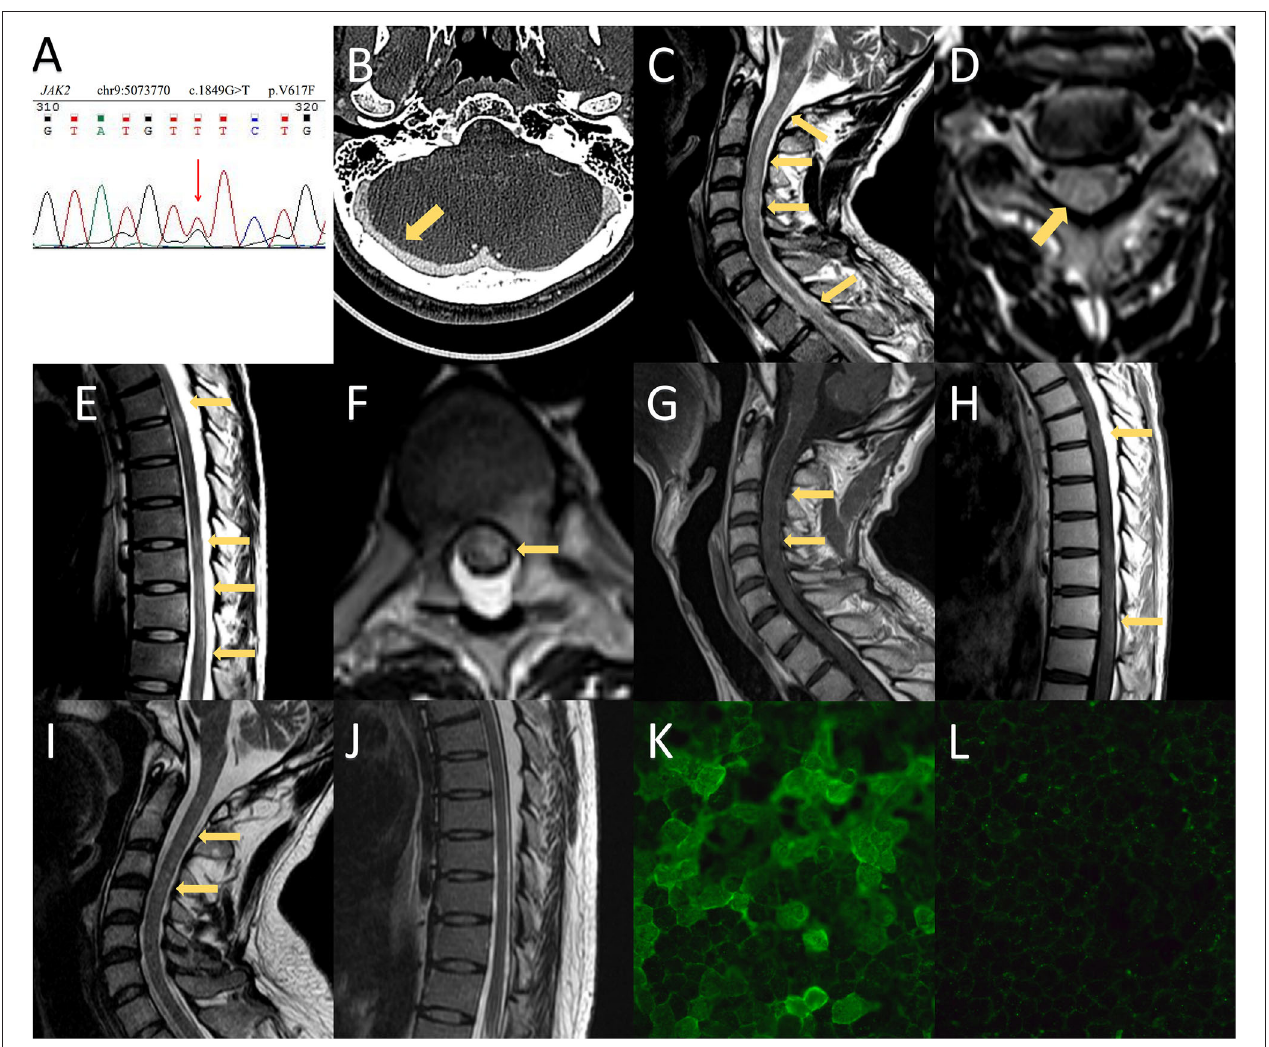
FIGURE 2 | MRI and CT findings and anti-aquaporin-4 antibody (AQP4-IgG) array of the presented case. (A) Whole-exome sequencing revealed a mutation in JAK2-V617F. (B) CT venography of the second hospitalization showed no filling defects of the cerebral venous sinus. (C–H) Spinal MRI demonstrated T2-weighted imaging abnormalities in the medulla as well as extensive spinal cord involvement extending from C1 to the conus. Spinal MRI with contrast showed mild enhancement in the cervical and thoracic spinal cord. (I,J) Follow-up MRI showed prominent regression of the hyperintense lesion, which included the medulla and spinal cord. (K) The serum titer of AQP4-IgG using a cell-based assay was 1:1,000 at the time of neuromyelitis optica spectrum disorder diagnosis. (L) The patient was negative for AQP4-IgG at the 1-year